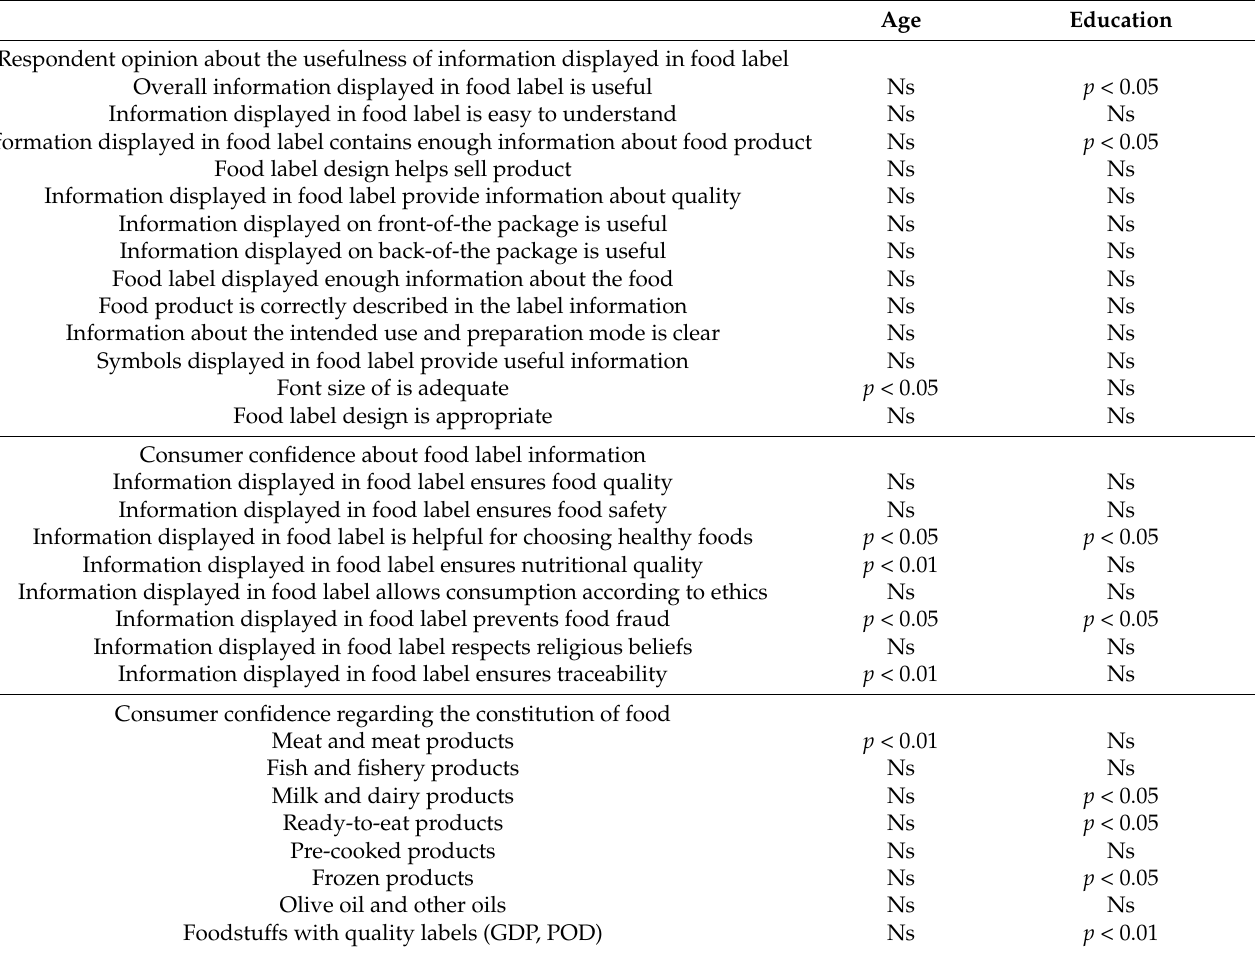
Table 2. Influence of socio-demographic characteristics in food label information, food label confidence and trust in food constitution (results p < 0.05 are statistically significant).